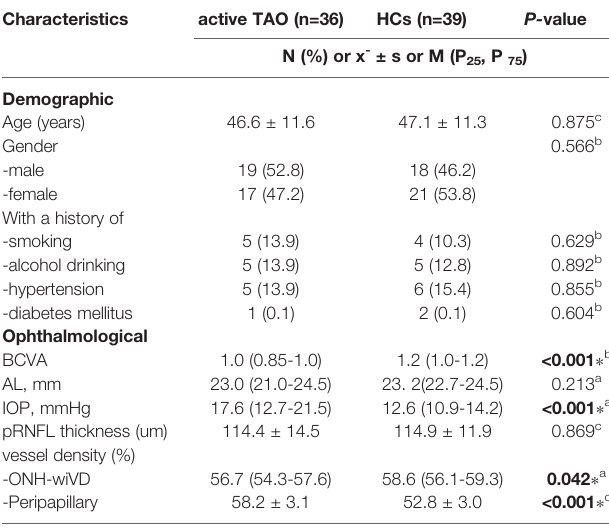
TABLE 1 | Demographic and ophthalmological characteristics between active TAO and HCs